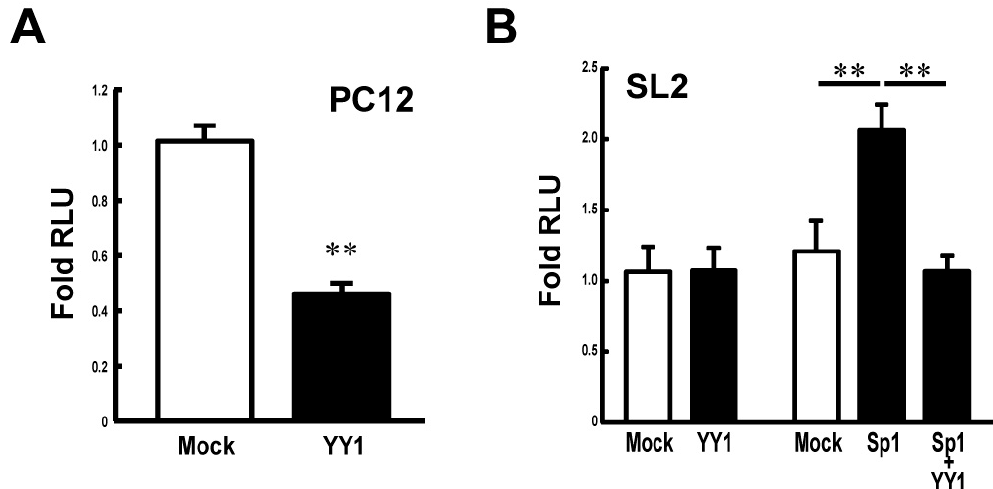
Figure 3. Effect of YY1 on the Stx1a transcription activity. ( A ): Reporter assay in PC12 cells overexpressing YY1. Reporter activity was measured in PC12 cells co-transfected with pGL3–CPR ( − 204 to +2) reporter vector and pcDNA–YY1 expression vector. Values represent means ± SE ( n = 9) from three independent experiments. ** p < 0.01 compared to the pcDNA-vector mock control. ( B ): Reporter assay in drosophila SL2 cells overexpressing YY1 and Sp1. Reporter activity was measured in SL2 cells transfected with reporter vector pGL3–CPR ( − 204 to +2) and expression vectors of pPac-Sp1 and -YY1. Values represent means ± SE ( n = 9) from three independent experiments. ** p < 0.01 compared to the pPac-vector mock control.